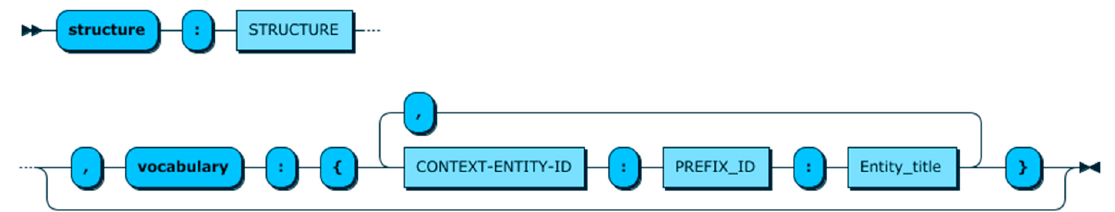
Figure 15. OUTPUT-CONFIG clause production rule.